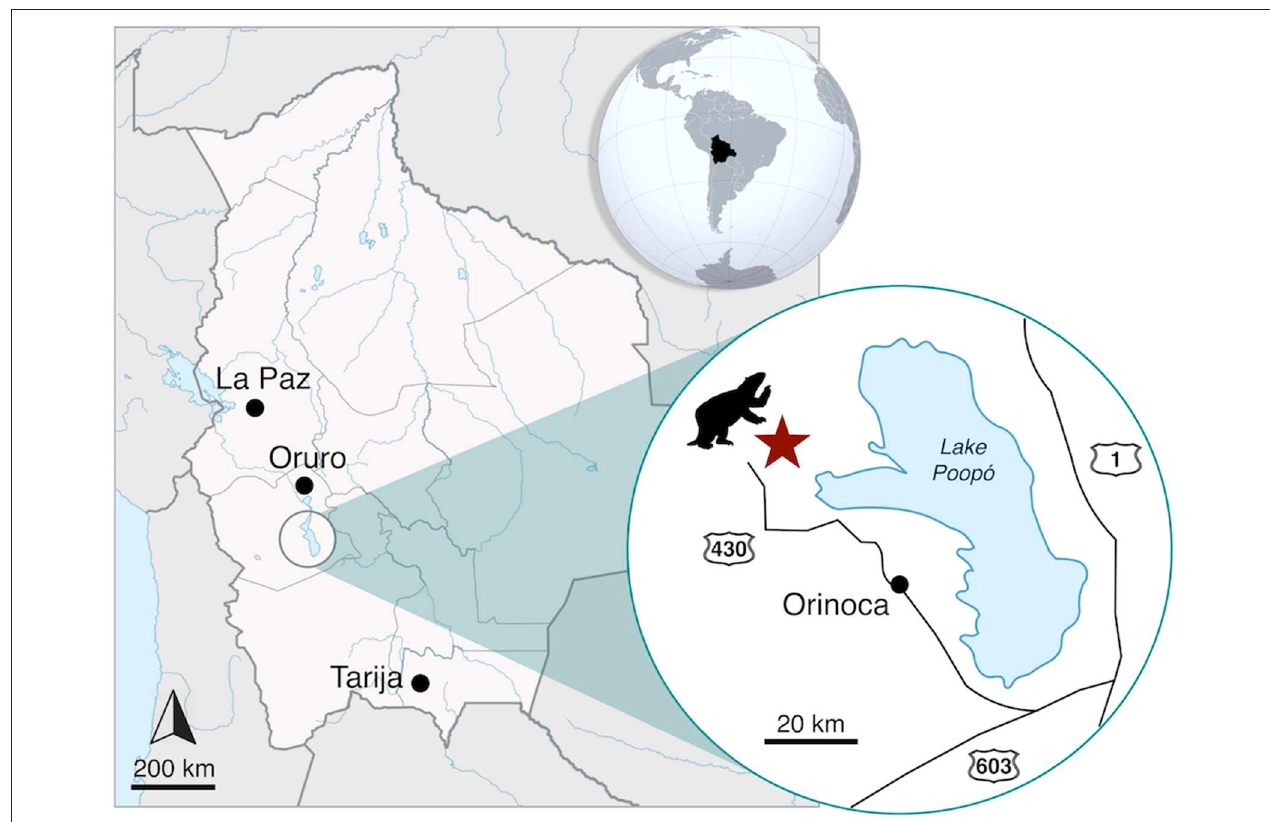
FIGURE 1 | Map of the locality in which the remains of Catonyx tarijensis MNHN-Bol V 13364 have been recovered. Circles: cities; Star: fossil locality.